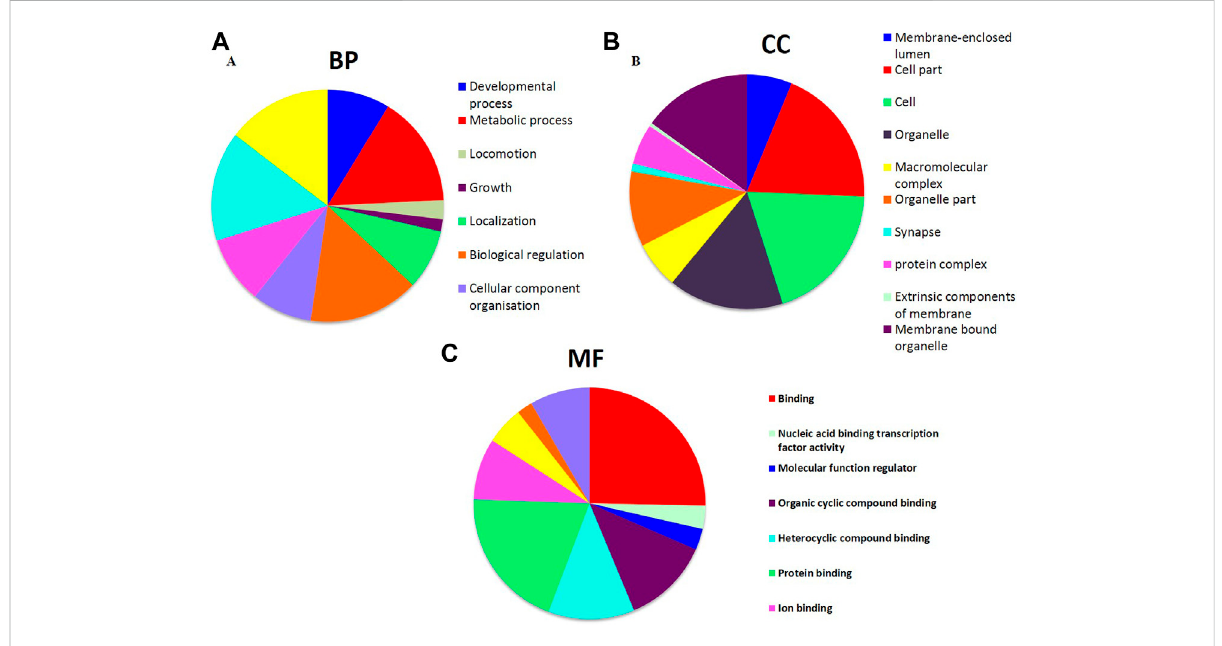
FIGURE 9 GO annotation for the predicted target genes of potential differentially expressed miRNAs. (A) Top ten enriched biological process (BP) for target genes of miRNAs. (B) Top tenenriched cellular component(CC) for target genes of miRNAs. (C) Top ten enriched molecular function (MF) for target genes of